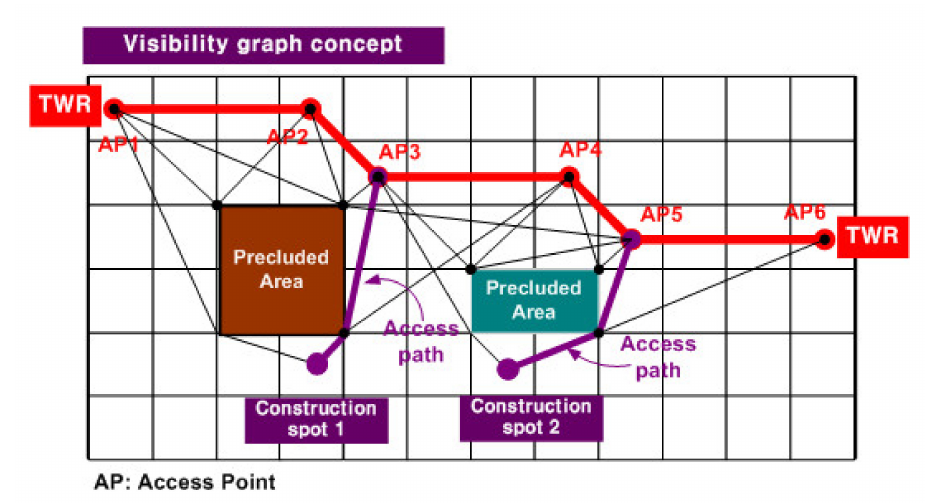
Figure 8. Access to a construction spot form the